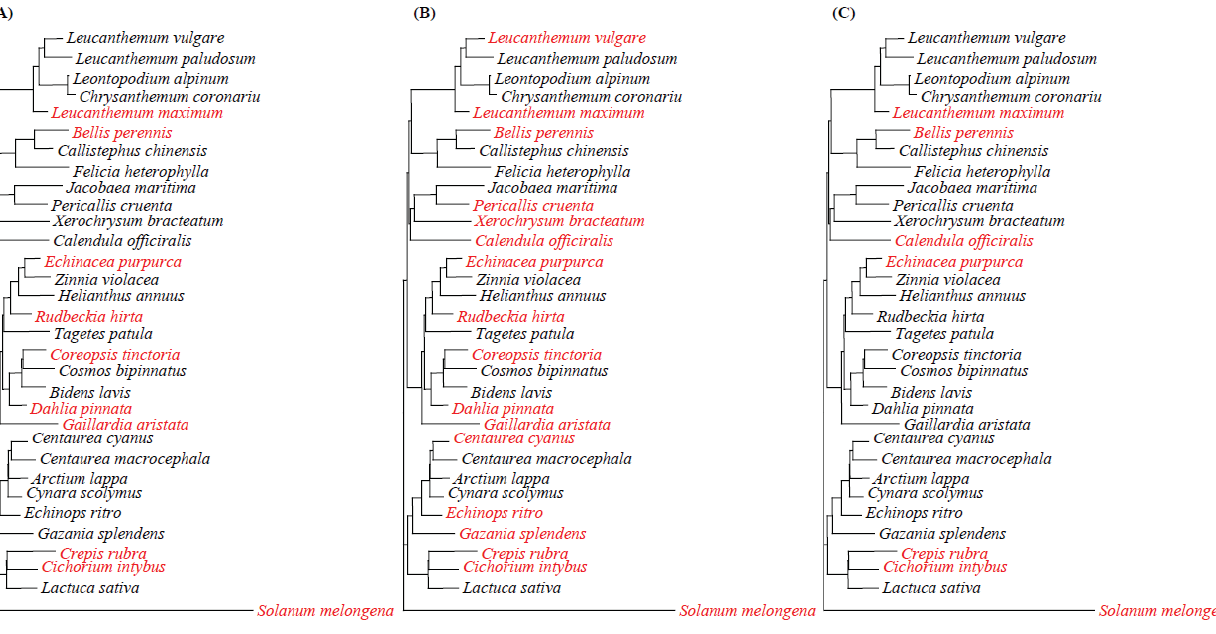
Figure 6. Relationship between the phylogenetic tree of Asteraceae plants based on the combined partial nucleotide sequences of ndhF and rbcL and virulence of SPC9018-hrcC ( A ), ΔaldH ( B ) and Δpat ( C ) on Asteraceae plants. The phylogenetic tree was constructed with Clustalw using the NJ method [22,23]. The scale bar indicates genetic distance, which is the expected number of substitutions per position. P. cichorii strains showed virulence and non-virulence on plants with black-colored and red-colored letters, respectively. The nucleotide sequences of the combined partial nucleotide sequences of ndhF and rbcL from eggplant ( Solanum melongena ) were used as the outgroup for phylogenetic tree